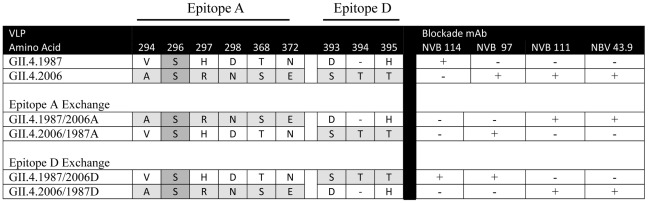
Summary of exchange mutant VLPs containing blockade Epitopes A and D and the reactivity pattern of the human mAbs that recognize these epitopes.